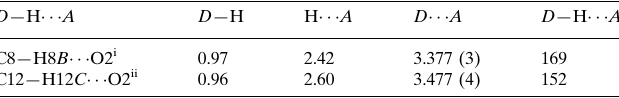
Hydrogen-bond geometry (A˚ , (cid:2)